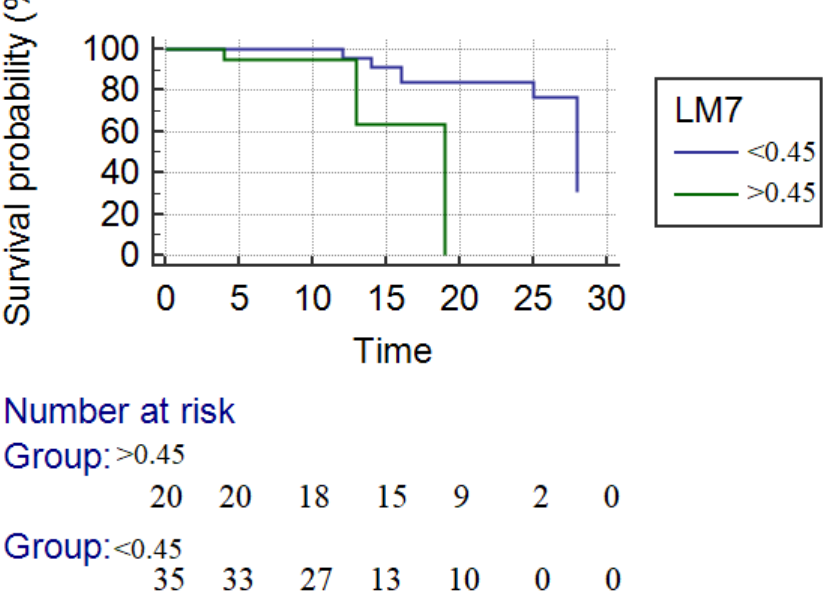
Figure 4. Kaplan–Meier survival analysis. The blue line represents the responders, and the green line represents the nonresponders to corticotherapy. The survival rate at 28 days in responders according to LM4 criteria was significantly higher compared with nonresponders (mean survival time—25.5 days vs. 16.3 days ( p = 0.04)).